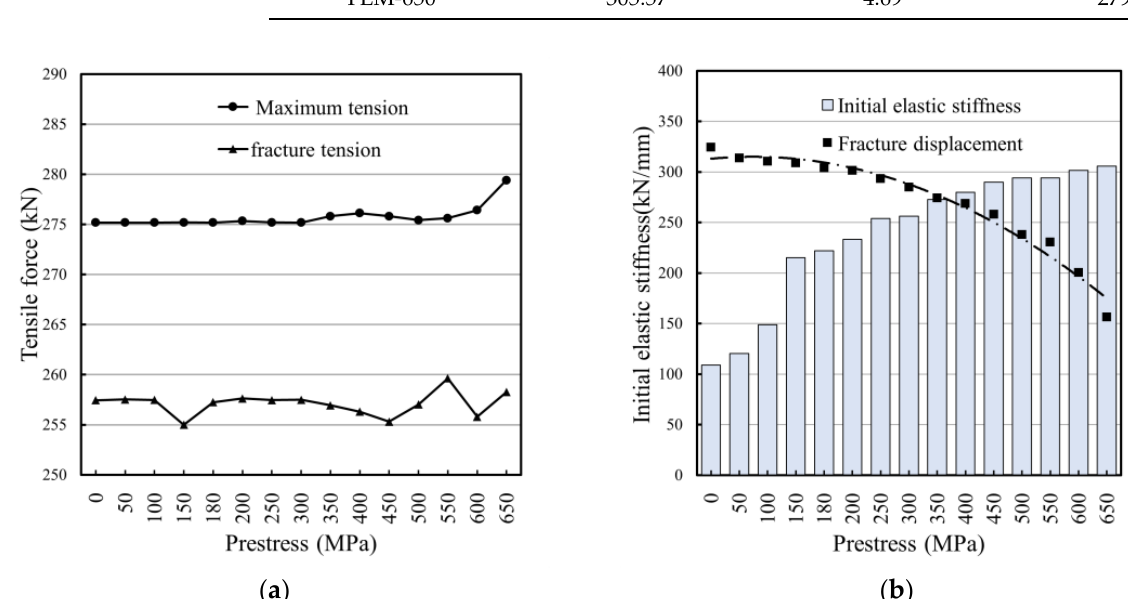
Figure 30. Response curves obtained from numerical simulation under different prestress.